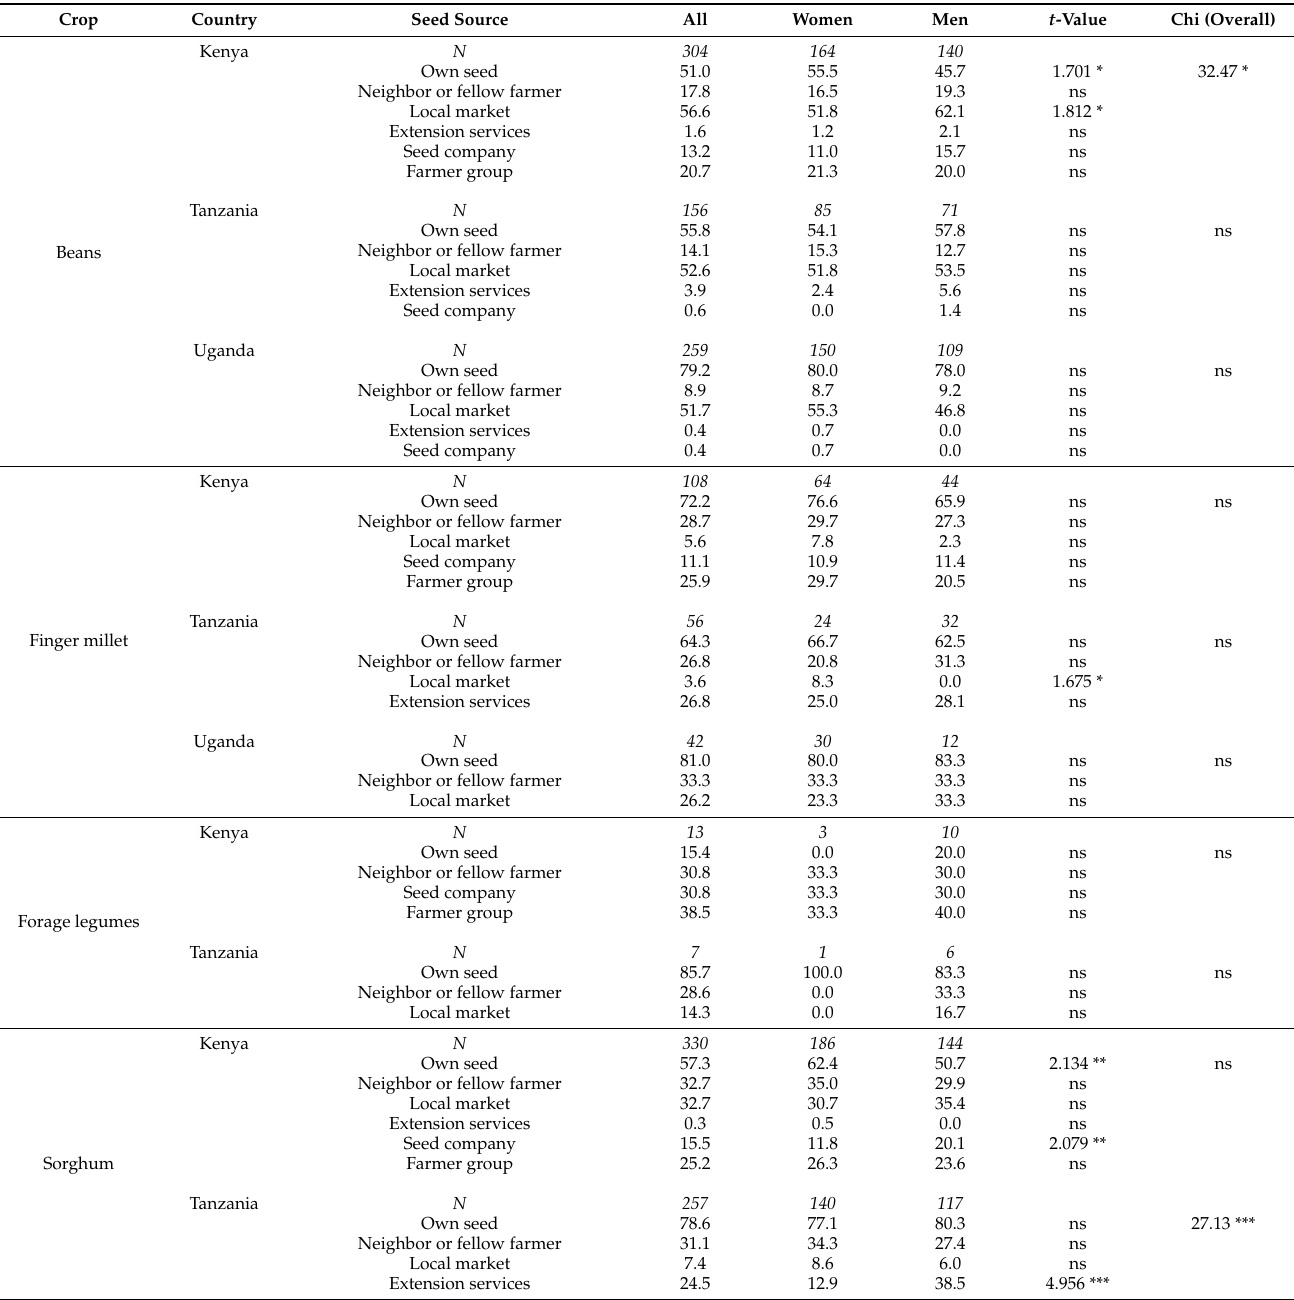
Table A3. Seed sources by crop, sex and country (% of